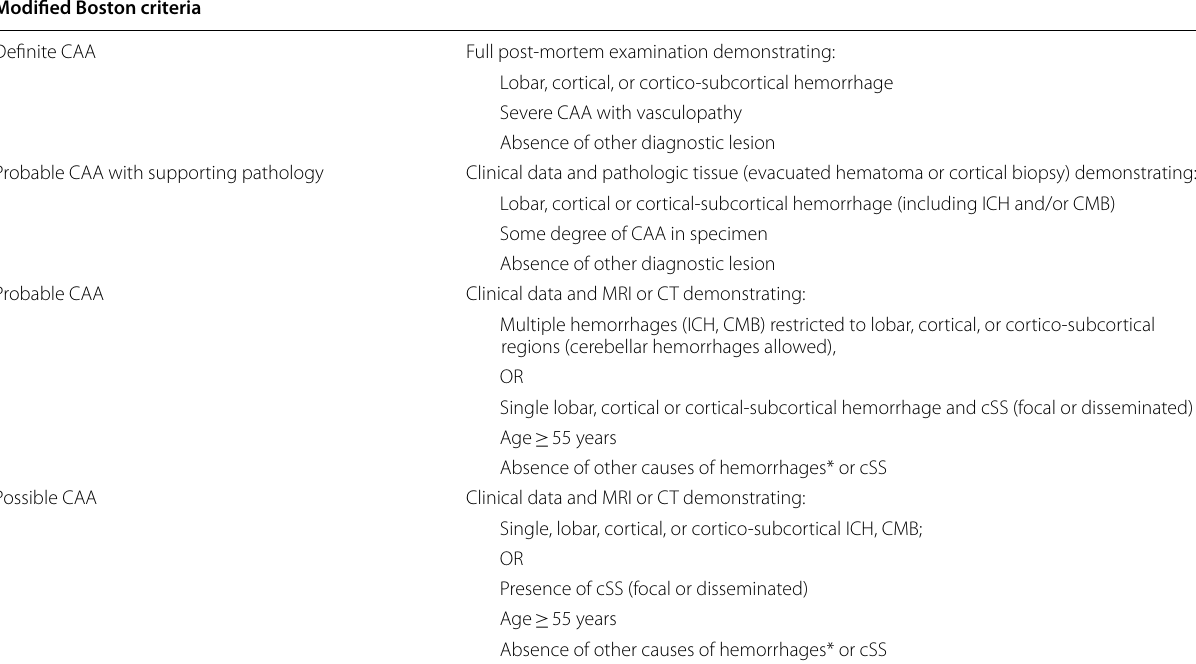
*Other causes of hemorrhage (differential diagnosis of lobar hemorrhages): antecedent head trauma, hemorrhagic transformation of an ischemic stroke, arteriovenous malformation, hemorrhagic tumor, warfarin therapy with international normalization ratio > 3, and vasculitis. CAA: cerebral amyloid angiopathy; MRI: magnetic resonance imaging; ICH: intracerebral hemorrhage; cSS; cortical superficial siderosis; CMB: cerebral